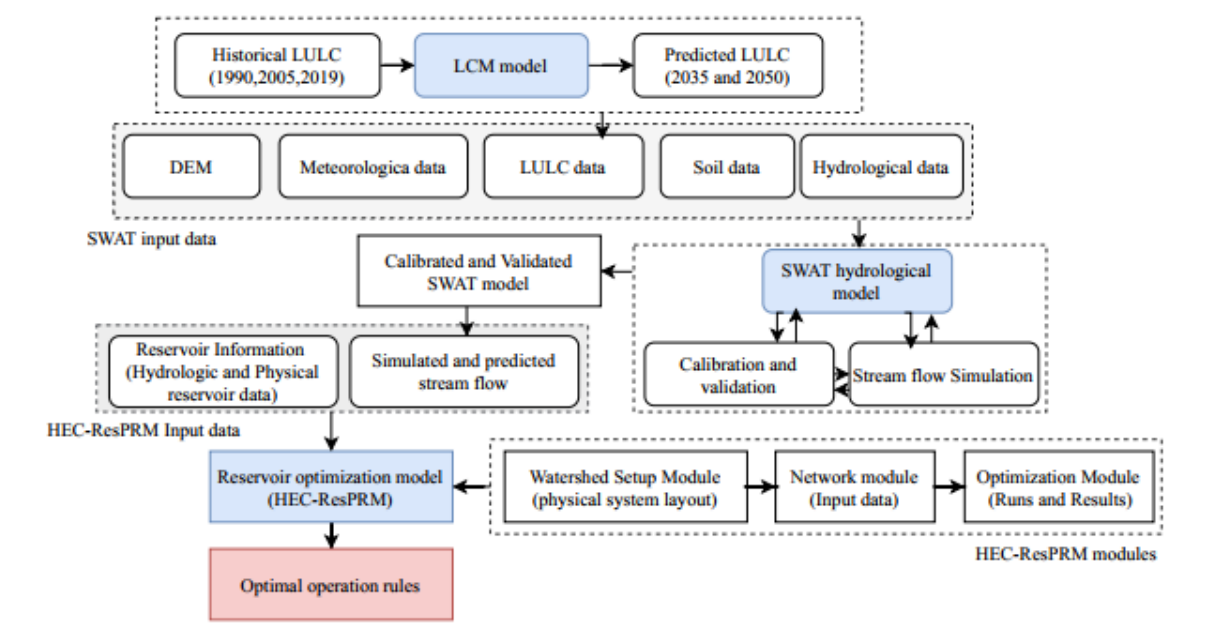
Figure 4. Framework of simulation-optimization model for reservoir operation.